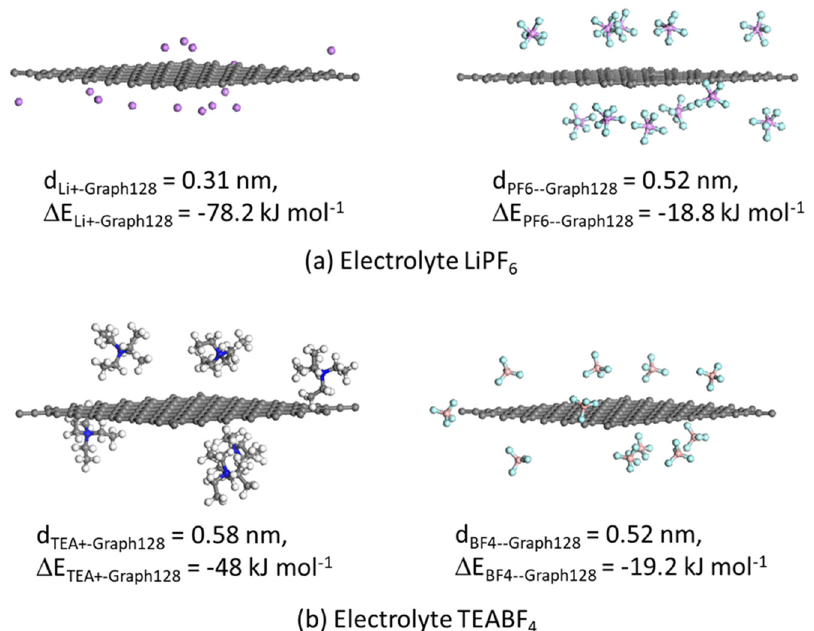
Figure 3. Graphite sheet with 128 C atoms, Graph128 (representing a-MWGO in this study), coordi- nated with either the desolvated cation or the desolvated anion of electrolyte ( a ) LiPF 6 and ( b ) TEABF 4 ; noted the average distance and the adsorption energy between Graph128 and the center of ion mass.